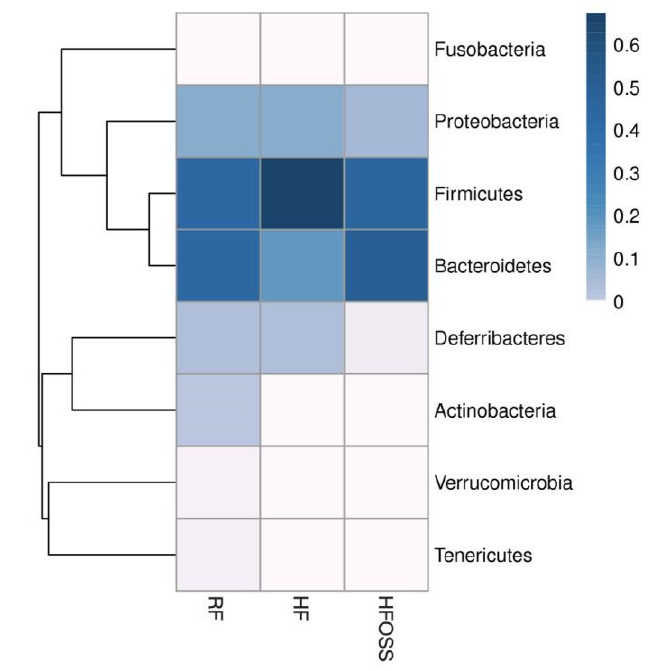
Figure 6. Phylum distribution heatmap of the fecal microbiota of mice fed a regular-fat diet (RF), high-fat diet (HF), and high-fat diet supplemented with OS starch (HFOSS). The colors in the heatmap represent the relative abundance of the corresponding phylum in the corresponding group.